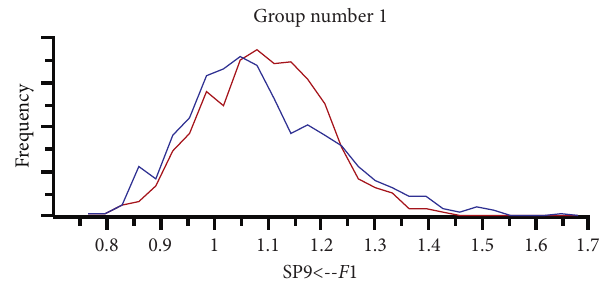
Figure 12: First and last combines polygon SP9.